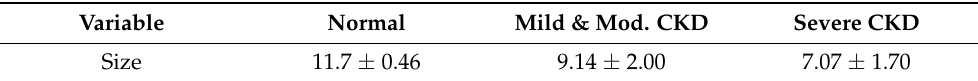
Table 7. The size of the normal kidney and that with mild and moderate CKD and severe CKD (mean ±